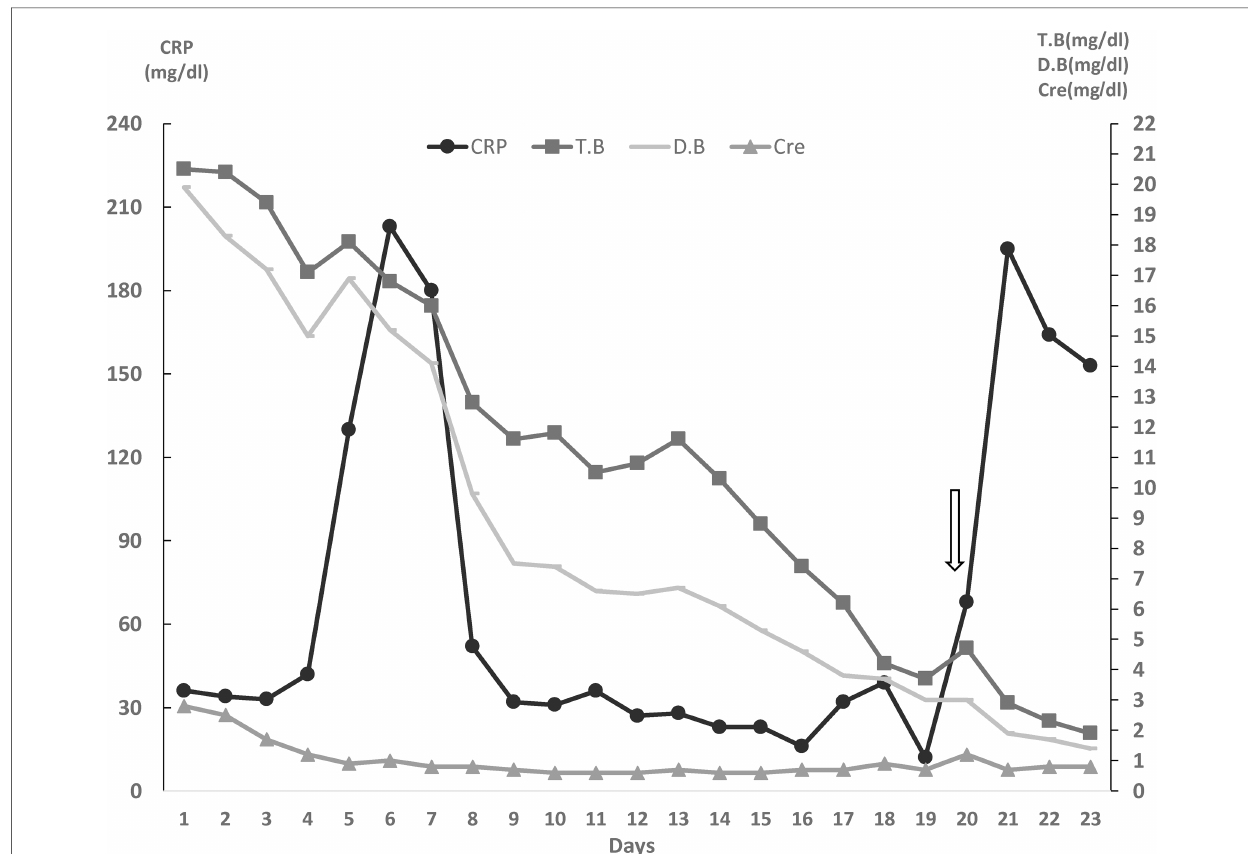
FIGURE 2 Clinical course of the patient during 23 days of hospitalization in the ICU. (Arrow represents the day in which Upper Gastrointestinal bleeding happened). CRP, C-reactive protein; CRE, creatinine; T.bil, total Bilirubin; D.bil, Direct